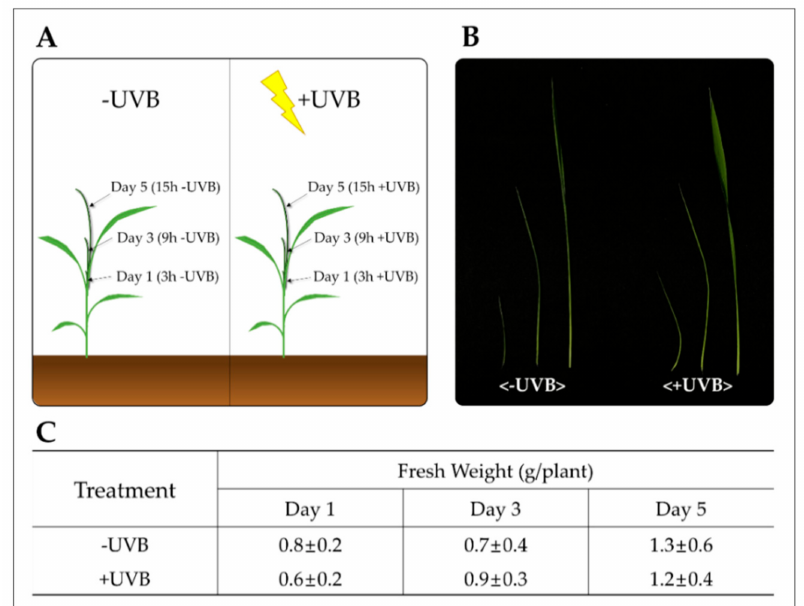
Figure 1. Development of leaf blades of rice seedlings: ( A ) growth of a leaf blade during the younger- to-older transition under − UVB (left) or +UVB (right); ( B ) fresh weight at 1, 3, and 5 days in both groups ( n = 5). ( C ) UVB irradiation took place at 30~35 cm from the canopy for five consecutive days (3 h/day − 1 ) as the new leaf blade (1~2 cm long) emerged from the previous leaf